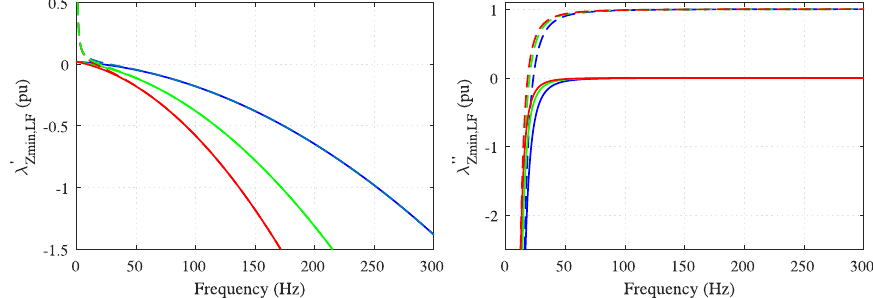
( left ) and λ (cid:48)(cid:48) ( right ) with L v = 0.2 pu and Zmin,LF Zmin,LF and Z (cid:48)(cid:48) . conv,LF conv,LF